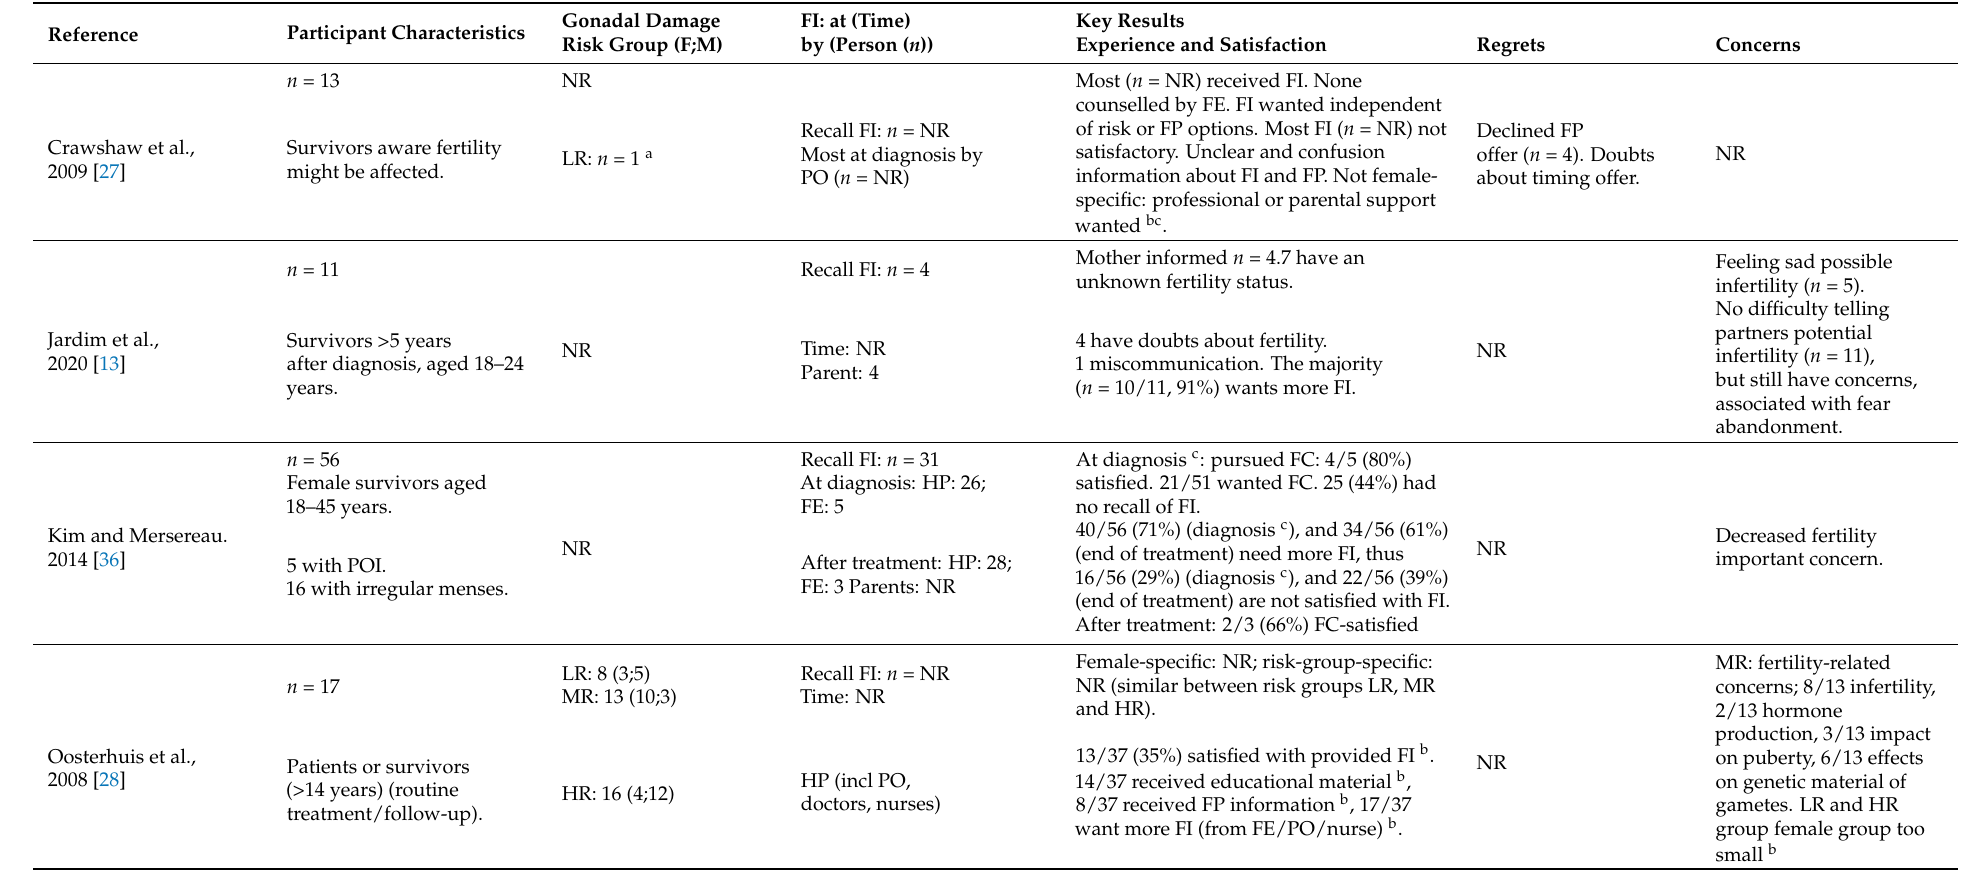
Table 3. Summary of experiences on obtained oncofertility information and counselling in a paediatric cancer